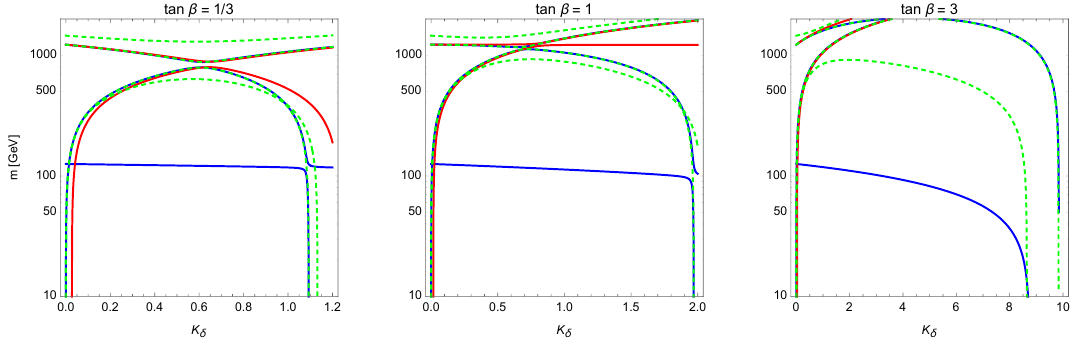
Figure 7 . Same as (cid:12)gures 5 and 6 for (cid:12)xed (cid:13) = 0 : 02, showing spectra for tan (cid:12) = 1 = 3, 1 and